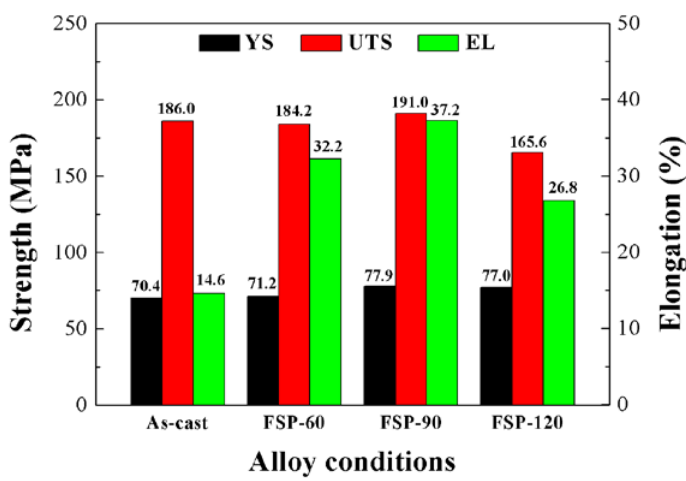
Figure 7. Mechanical properties of the as-cast and FSP Mg–6Sn–2Zn samples: As-cast represents the as-cast sample and FSP-60, FSP-90, and FSP-120 represent the FSP Mg–6Sn–2Zn samples with travel speeds of 60 mm/min, 90 mm/min, and 120 mm/min, respectively.